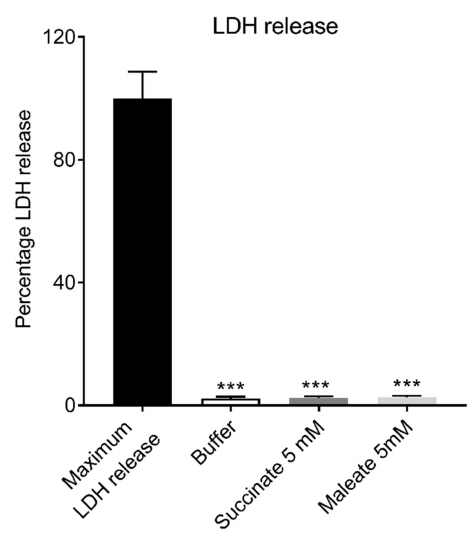
Figure 4. Both succinate and maleate inhibited lactate dehydrogenase (LDH) release from STC-1 cells. Results were expressed as mean ± SEM, n = 4. * p < 0.05, ** p < 0.01, *** p <